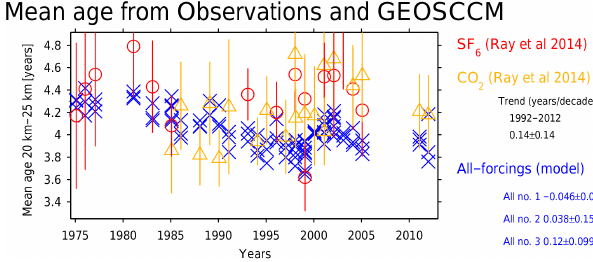
Figure 11. Mean age estimates in the data from Fig. 7 of Ray et al. (2014) in the NH mid-stratosphere between 20 and 25km and in the three all-forcing integrations for the same days. The trend from 1992 to 2012 is included. Note that in computing the trends we do not include any information as to the difference in uncertainty among the measurements for the Ray et al. (2014) data because all samples in GEOSCCM have the same uncertainty, and we prefer to use the same statistical test for both data sources for consistency. This leads to overly conservative estimates on the uncertainty for the Ray et al. (2014) data.